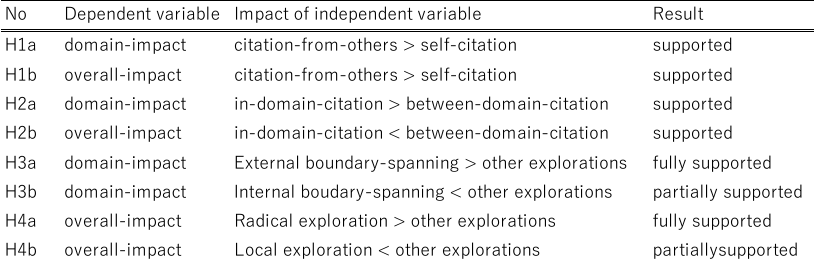
Table 2. Summary of the